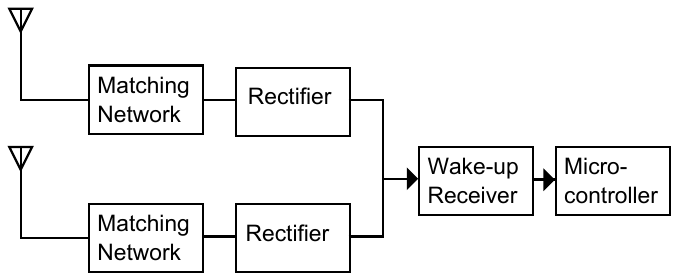
Figure 3. Block diagram of a low-power wake-up receiver with antenna diversity. Each diversity branch consists of antenna, matching network and rectifier.